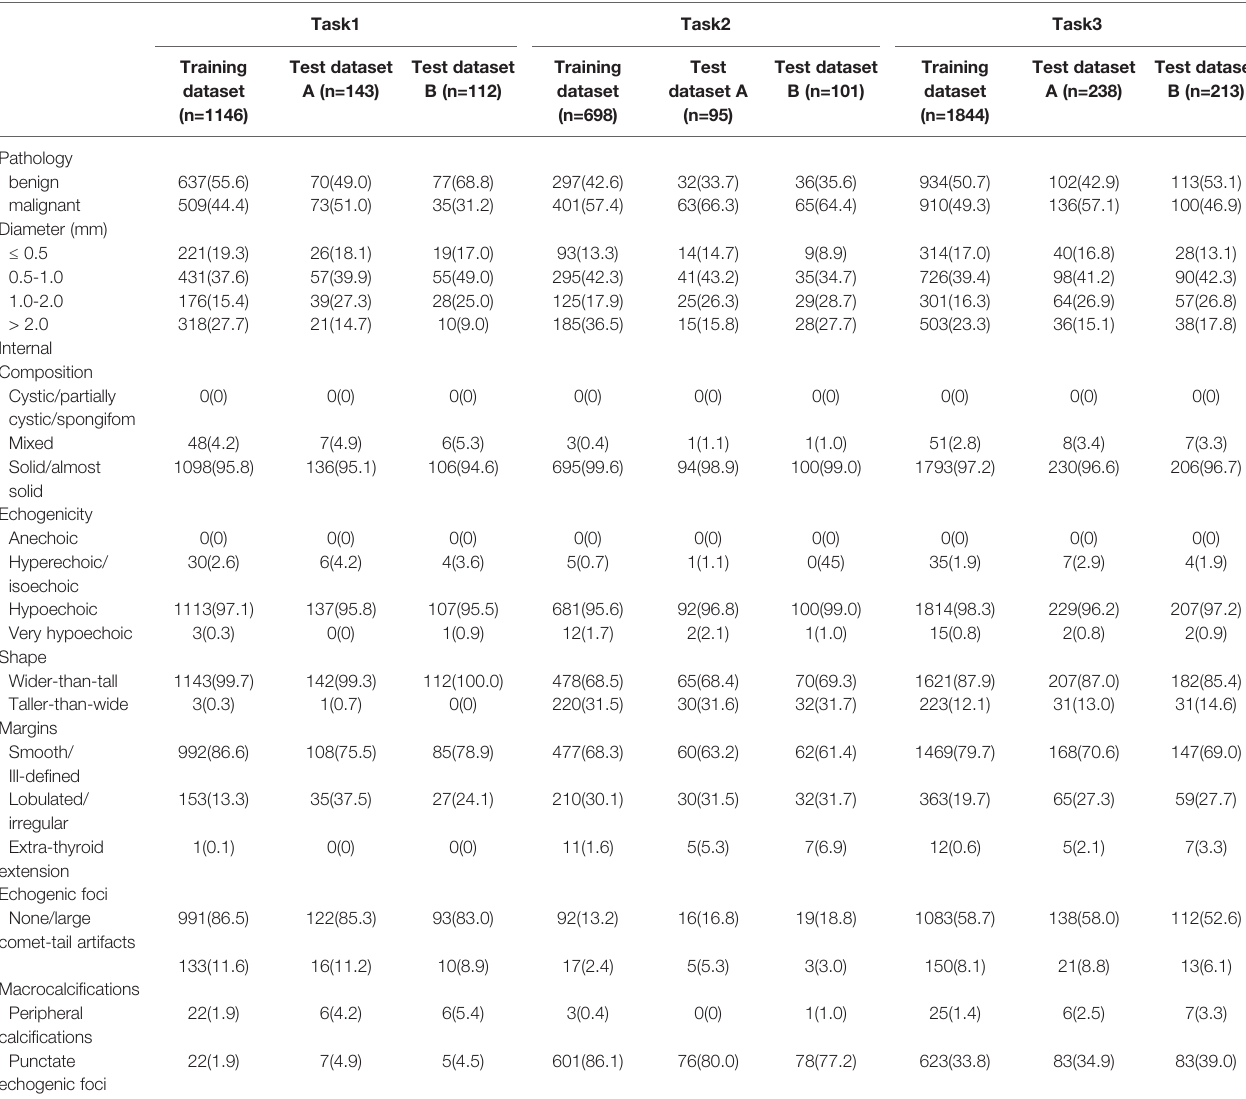
TABLE 2 | Characteristics of the thyroid nodules in internal set enrolled in this